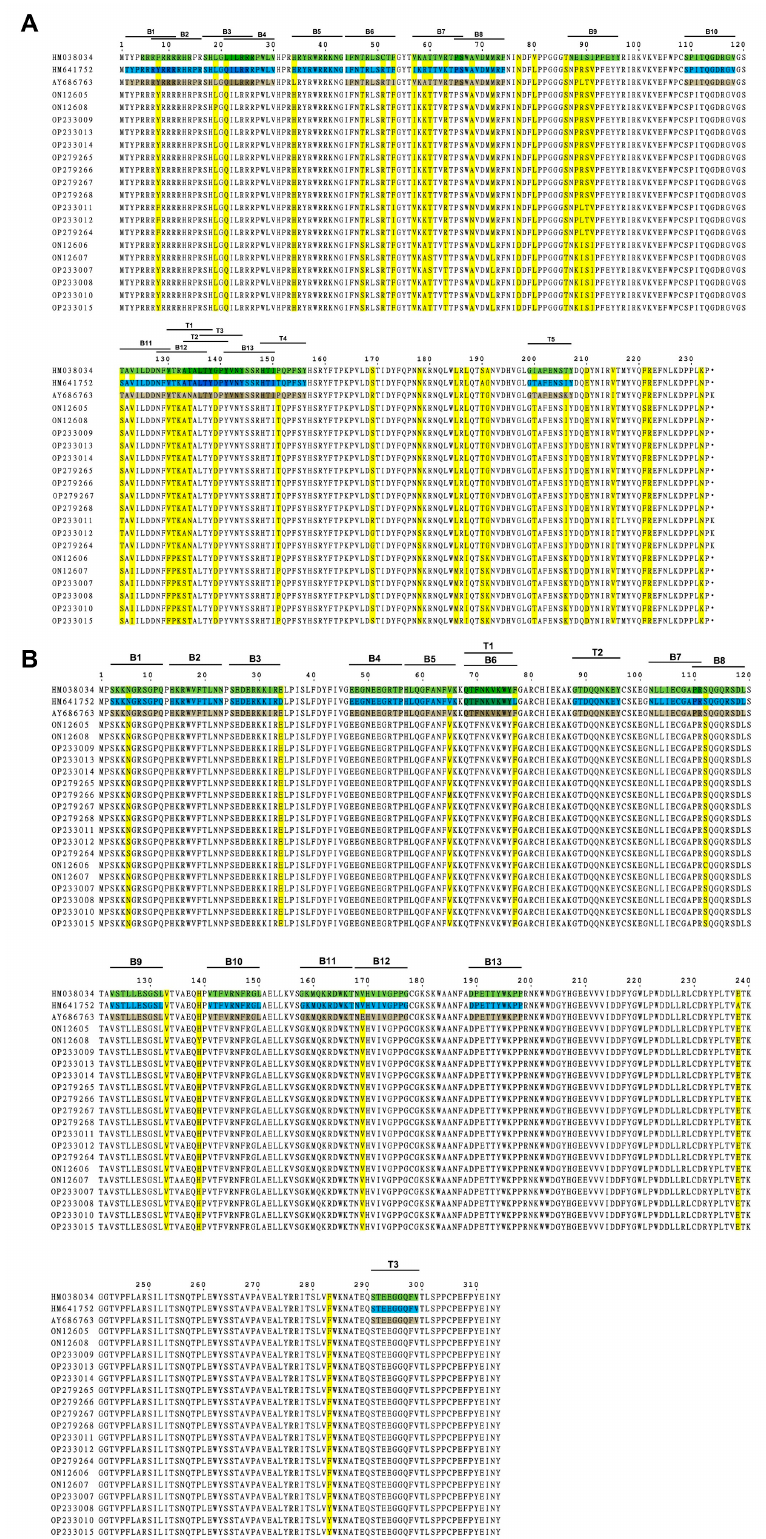
Figure 4. Mutation and epitope analysis of the PCV2 isolates. ( A ) Amino acid sequence alignment and potential epitopes of the PCV2 Cap protein. ( B ) Amino acid sequence alignment and potential epitopes of the PCV2 Rep protein. The epitopes of AY686763 Cap/Rep protein are brown, and that of HM641752 and HM038034 Cap/Rep protein are labeled in blue and green, respectively. Mutations are highlighted in yellow. B, B cell epitope; T, T cell epitope.